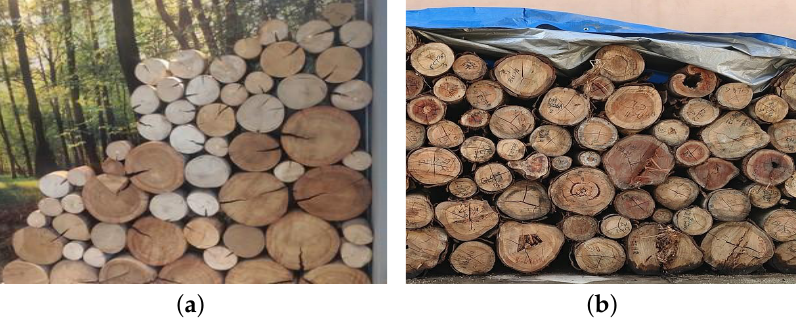
Figure 2. Wood stacks used in measurements. ( a ). Wood stacks indoors. ( b ). Wood stacks outdoors.